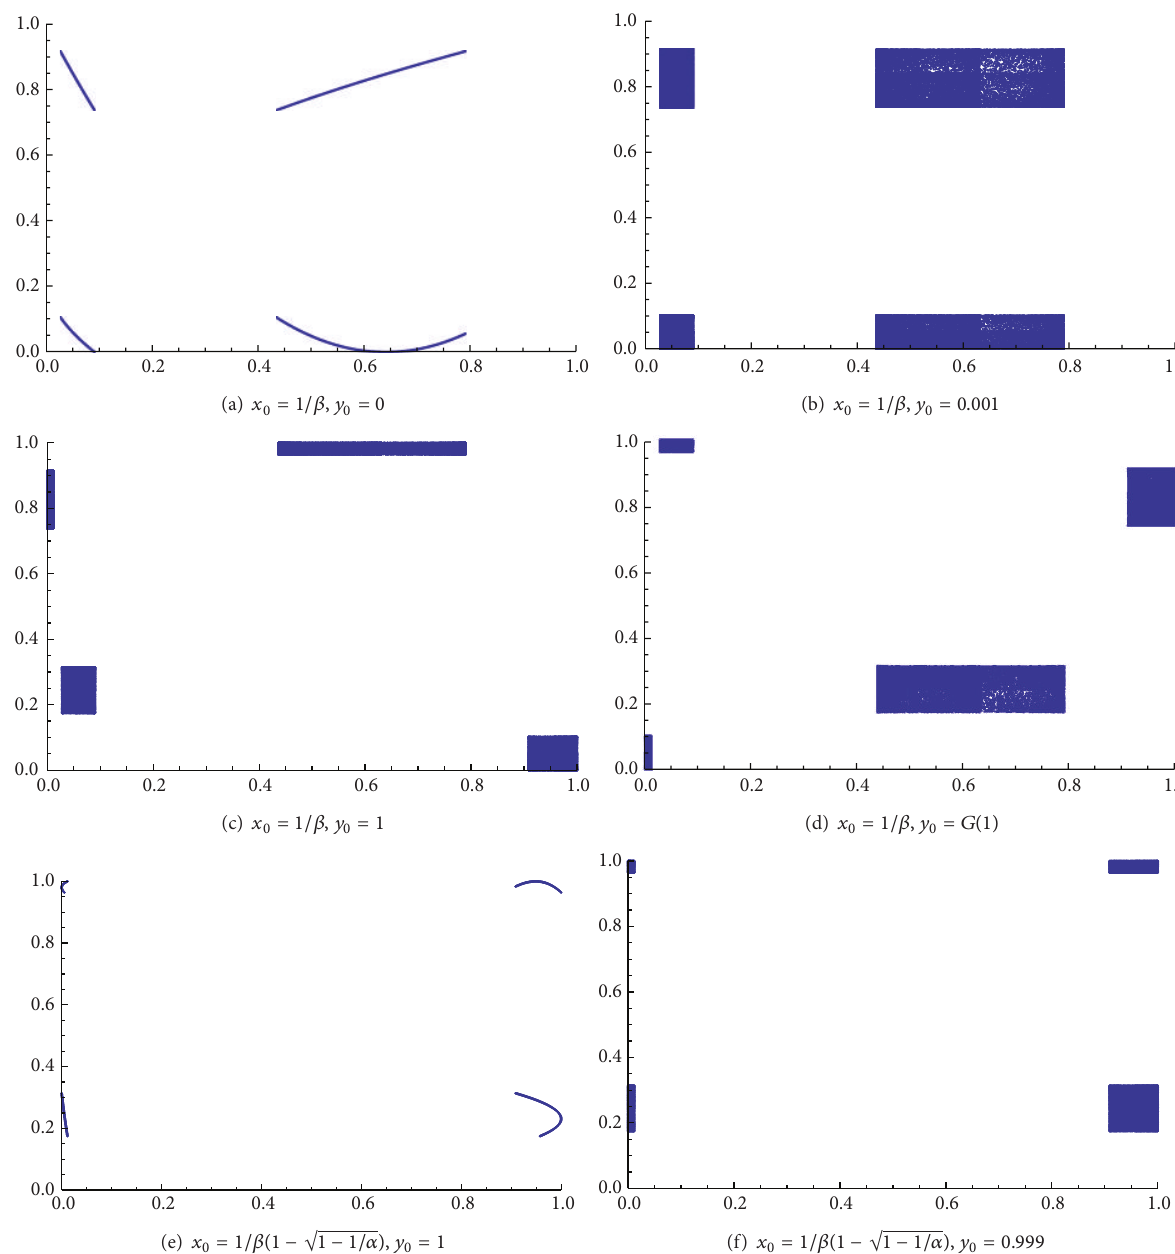
Figure 11: For 𝛼 = 1.3 and 𝛽 = 1.56 , we make 200000 iterations and draw the last 100000 in the 𝑋𝑌 -axis. Except for (b) and (e), the initial conditions are taken to be the extremum of 𝐹 𝛼,𝛽 and 𝐺 𝛼,𝛽 . (a) and (e) are not attractors because the initial conditions are synchronized;